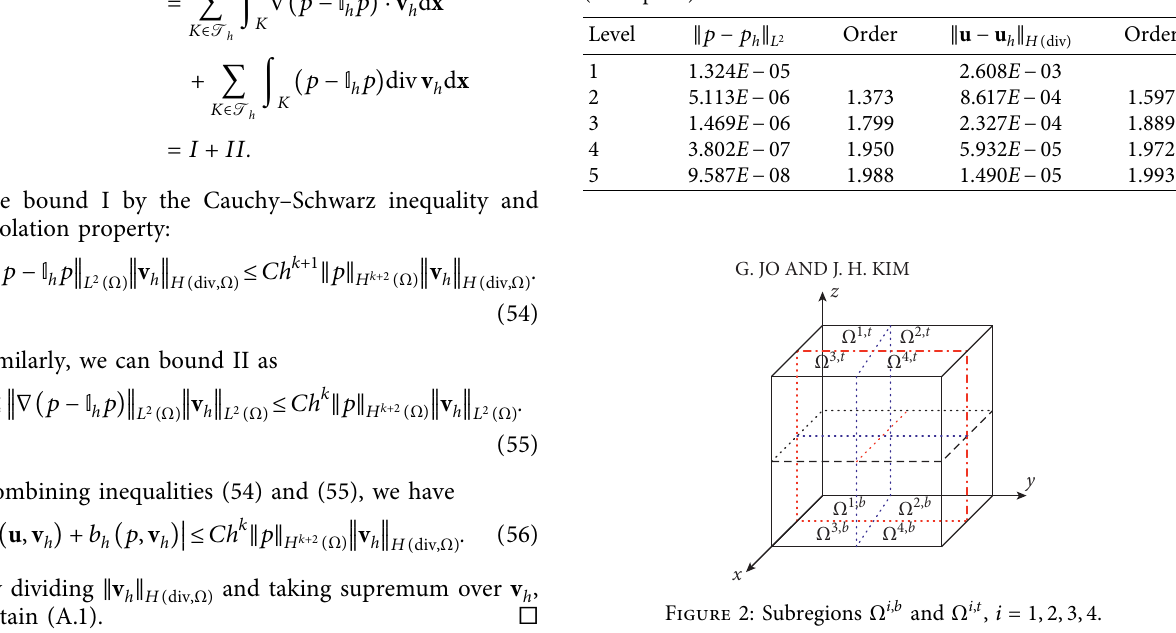
Table 2: L 2 -error for pressure and H ( div ) -error of velocity (Example 2).